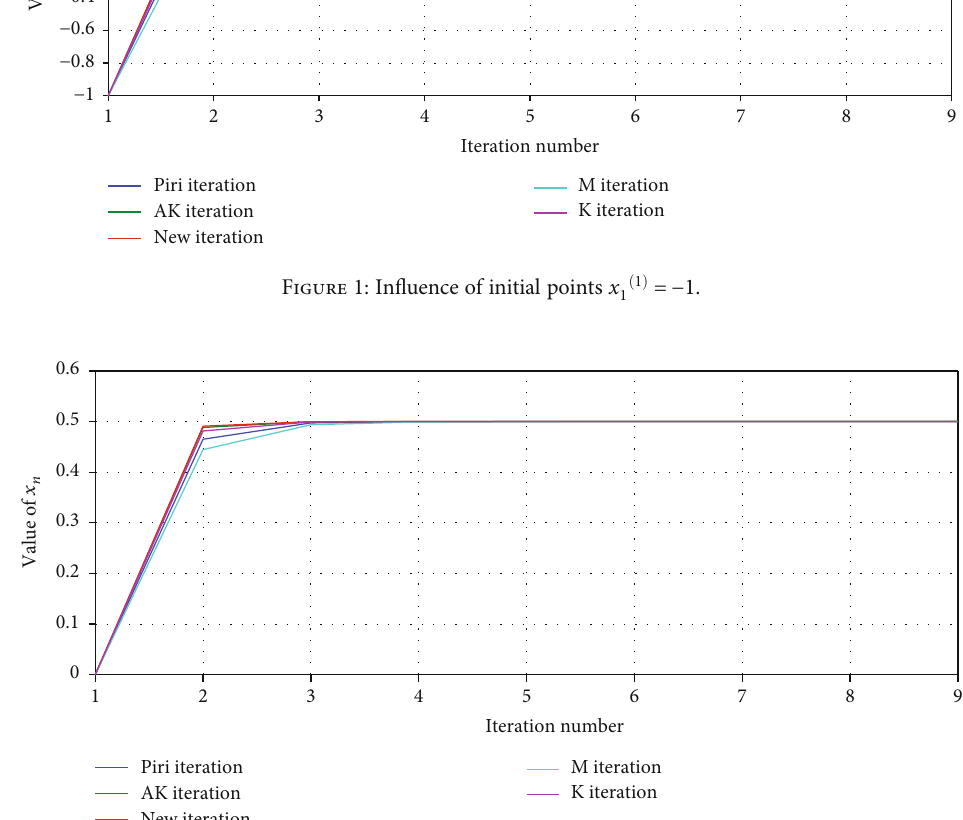
Figure 2: In fl uence of initial points x